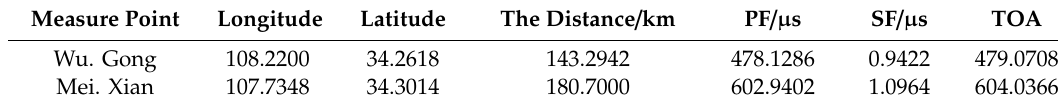
Table 6. The information of the measurement point.